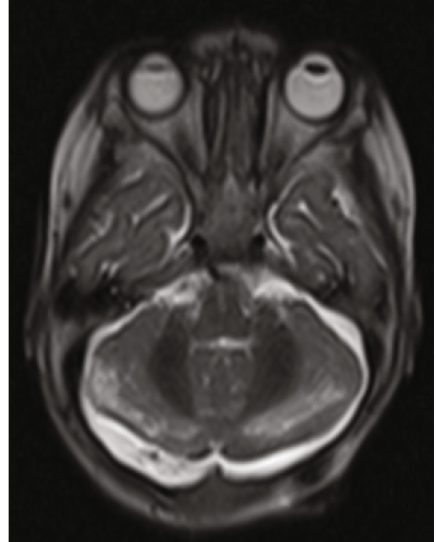
Figure 5: MRI evaluation 3 weeks after initial presentation. Axial T2-weighted image through the cerebellum three weeks after presentation shows volume loss and bright signal in the cerebellar hemispheres consistent with encephalomalacia in the regions of previous cerebellar injury and di ff usion